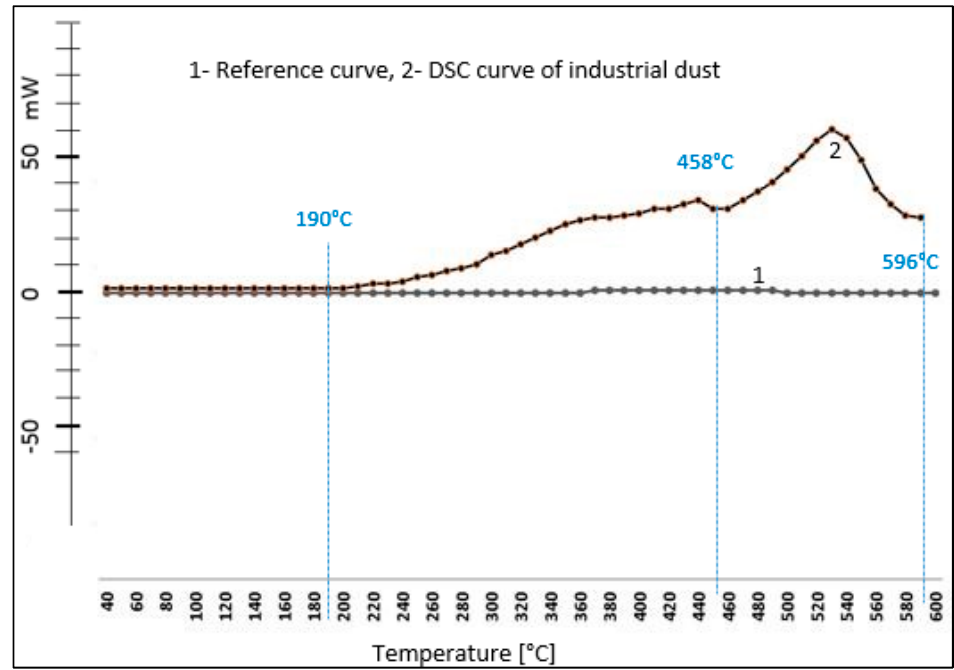
Figure 4. Description of what is differential scanning calorimetry (DSC) analysis of industrial dust.